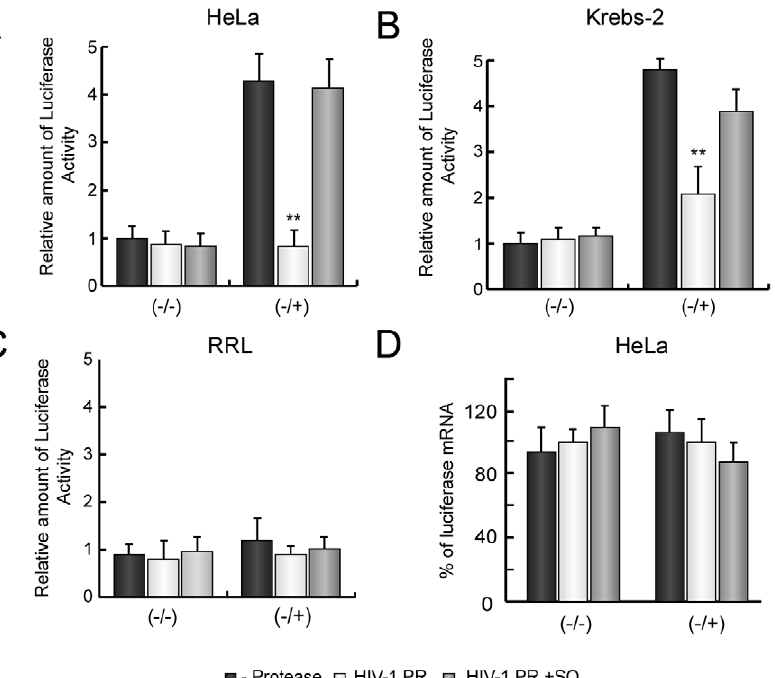
Figure 3. Analysis of poly(A)-dependent translation of luc mRNAs in HIV-1 PR treated HeLa extracts. HeLa (A), Krebs-2 (B) extracts or RRL (C) were treated with 20 ng HIV-1 PR for 30 min. Next, SQ 2.5 m M was added to the translation reaction to inhibit the protease activity. At this time point, extracts were programmed with 200 ng ( 2 / 2 ) or ( 2 / + ) mRNAs. As a control, a replicate reaction was incubated with 2.5 m M SQ from the beginning of incubation (grey bars). Luc activity was analyzed 30 min later and relative Luc activity from two independent experiments was represented. D) In parallel, RNAs were isolated from HeLa extracts and the amount of luc mRNA was determined by real-time RT-PCR. Relative luc mRNA levels were then represented. *P , 0.05; **P ,